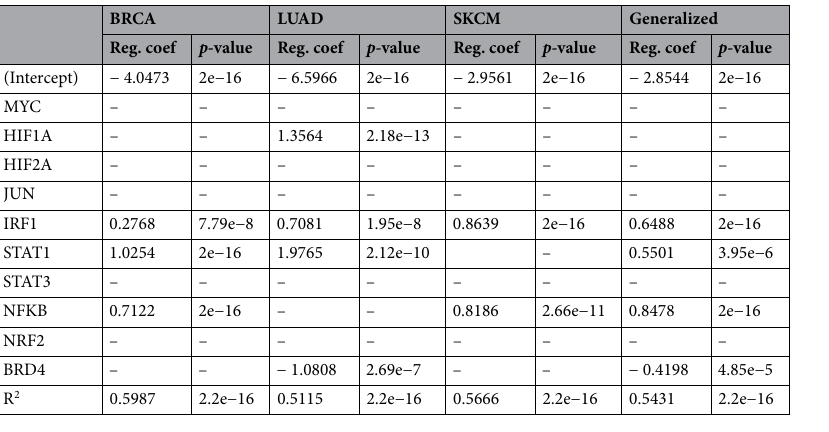
Table 1. Fitted coefficients and p -values of linear regression model per cancer type. A missing regression coefficient (i.e., a dash) indicates that the given transcription factor was not included in the